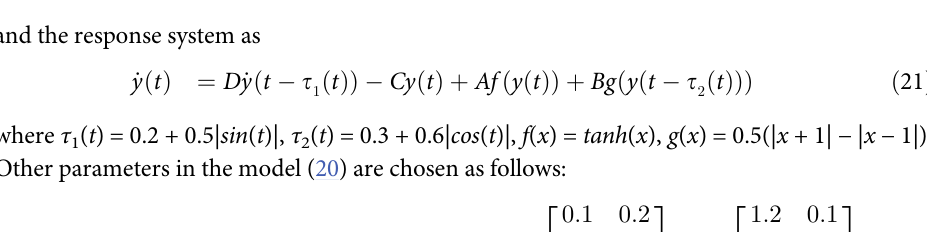
Fig 8. The second dimensional error curves ( e i 2 , i = 1, 2, 3) of drive-response systems (18) and (19) with the controller (8).